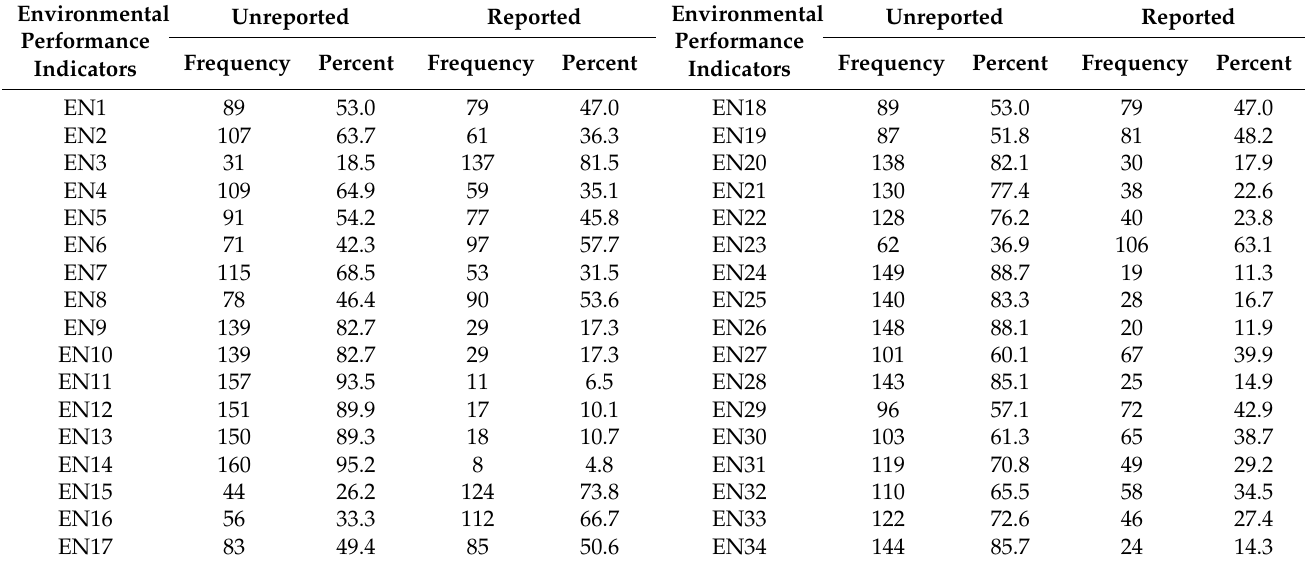
Table 5. Environmental performance indicator